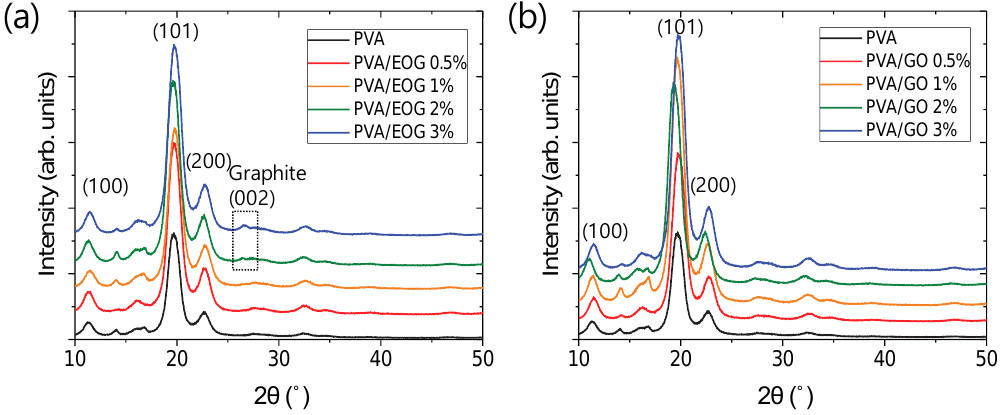
Figure 2. Comparison of the X-ray diffraction profiles of polyvinyl alcohol (PVA)-only fibers with those of ( a ) PVA/edge-selectively oxidized graphene (EOG) and ( b ) PVA/graphene oxide (GO) composite fibers.